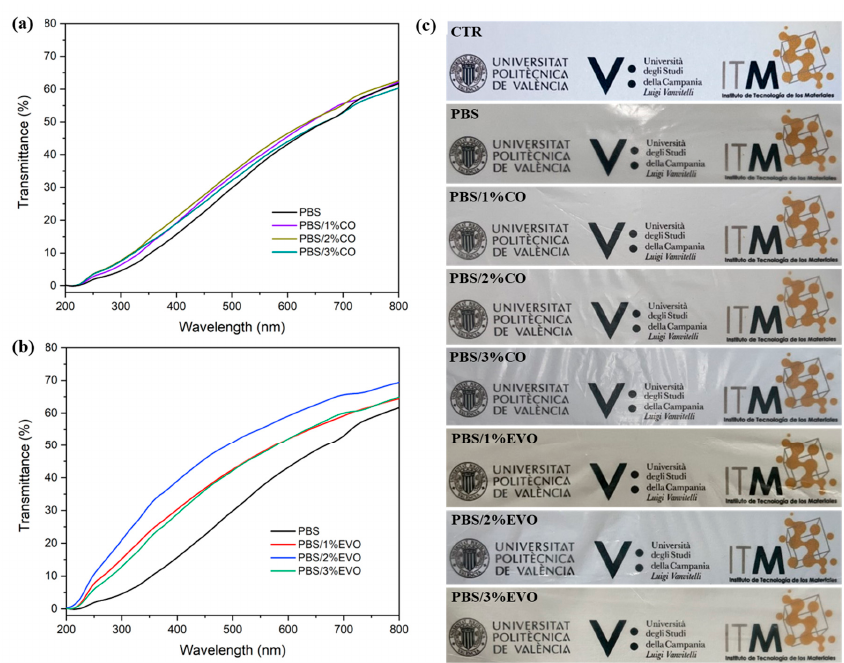
Figure 7. UV–Vis analysis of ( a ) PBS and PBS/CO formulations and ( b ) PBS and PBS/EVO formula- tions and ( c ) visual appearances of all PBS-based films/formulations.